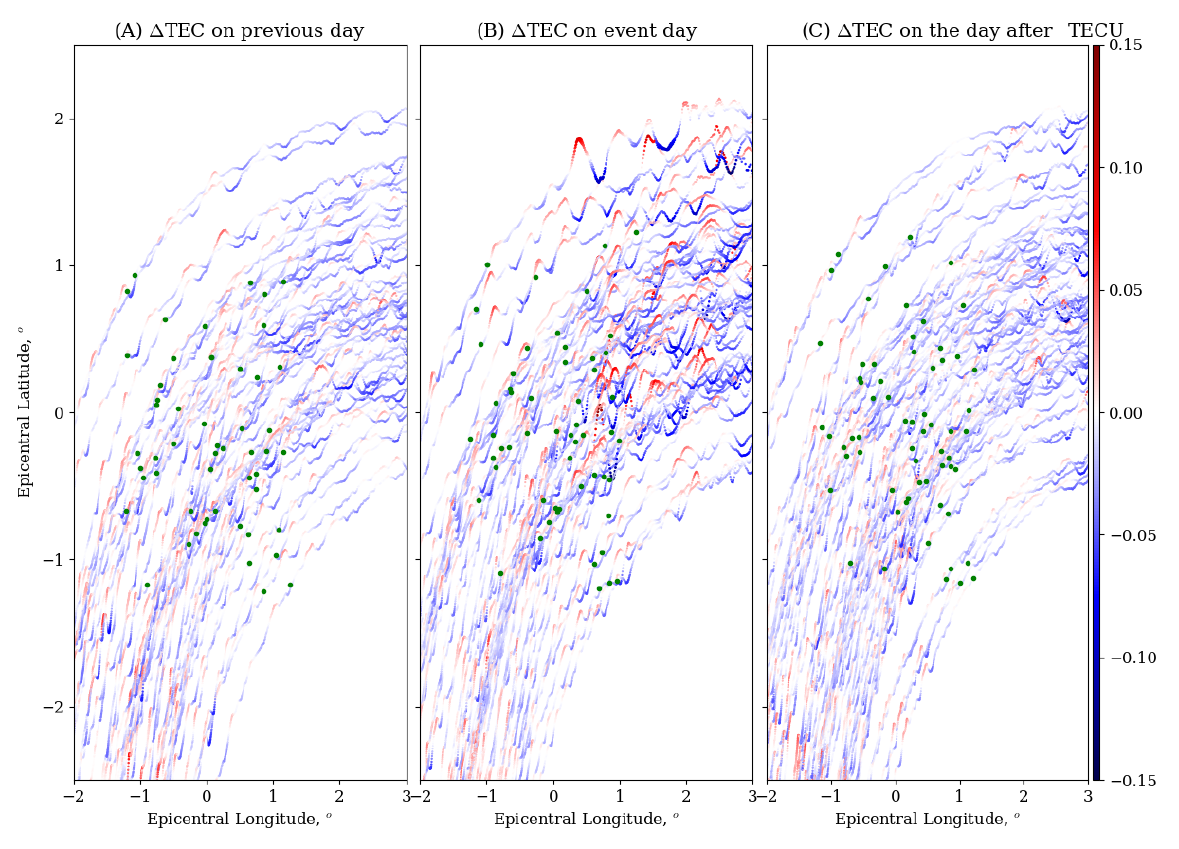
Figure 3. TEC disturbance ( ∆ TEC) along the IPP trajectories (trajectories are from left to right) in the vicinity of the epicenter on the previous day on 3 July ( A ), on the event day on 4 July ( B ), and on the day after on 5 July 2019 ( C ). The disturbances were extracted from the raw TEC data by applying a bandpass moving average filter with a parameter of 1–10 mHz. Small circles represent the locations of the IPP at the mainshock time. The epicentral latitude and longitude are defined as lat − lat ep and lon − lon ep ,